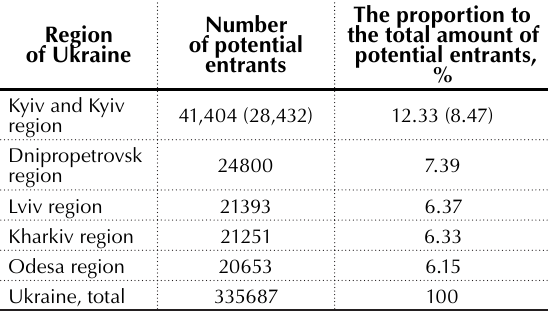
Table 2. TOP-5 regions of Ukraine by the number of potential entrants in